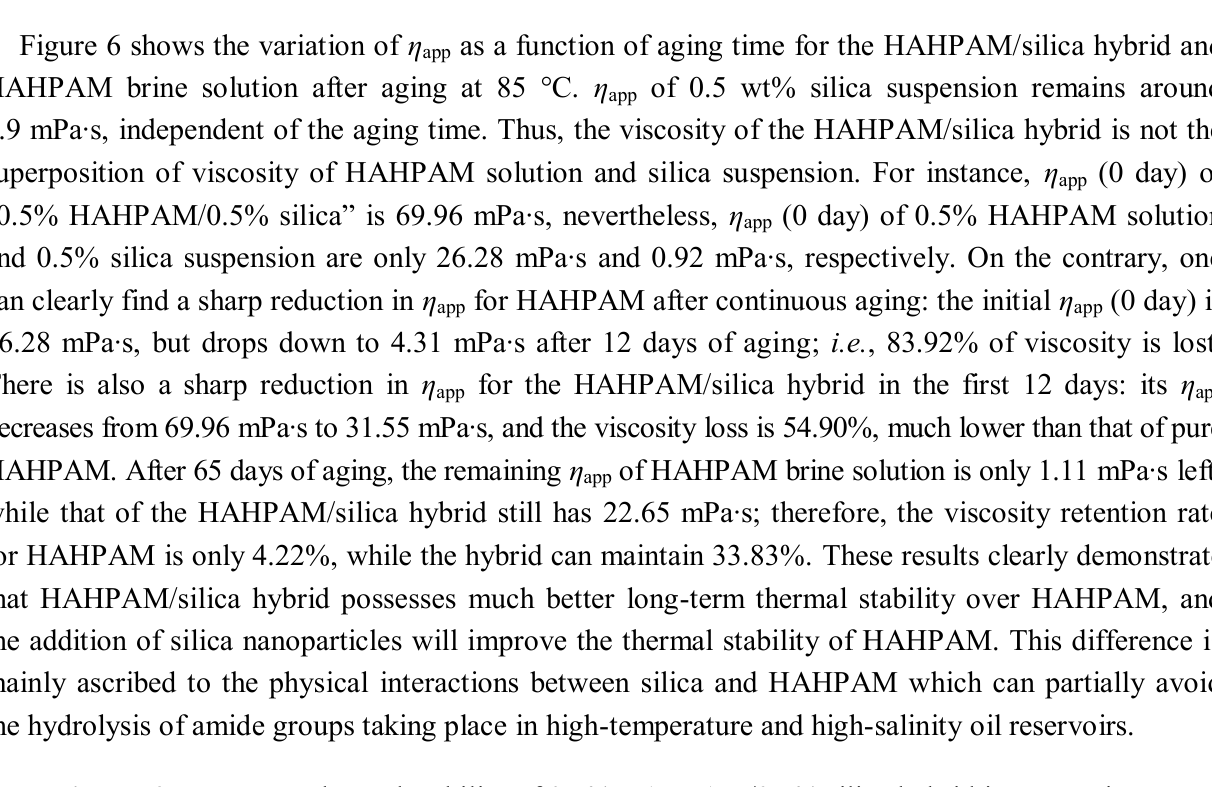
Figure 6. Long-term thermal stability of 0.5% HAHPAM/0.5% silica hybrid in comparison with 0.5% HAHPAM and 0.5% silica (TDS = 32,868 mg∙L −1 , [Ca 2+ ] + [Mg 2+ ] = 873 mg∙L −1 ,   = 10 s −1 ). Both the aging and measuring temperature is 85